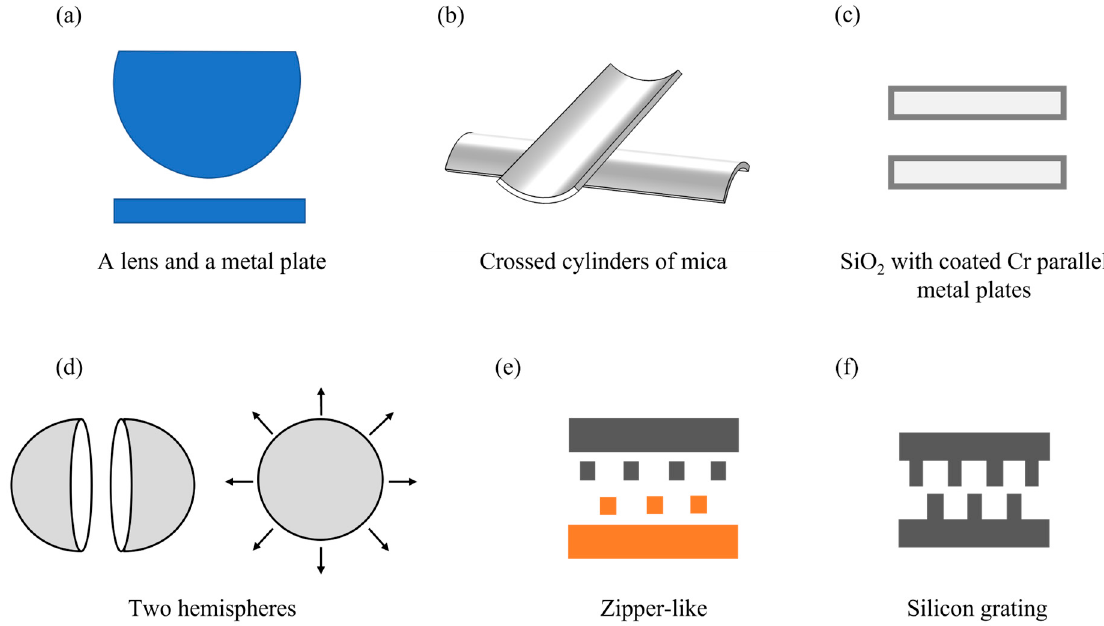
Figure 2. Examples of different geometries demonstrating the existence of Casimir forces: ( a ) a lens and a metal plate [21], ( b ) two crossed cylinders of mica [27], ( c ) two metal plates [23] ( d ) two hemispheres [24], ( e ) a zipper-like geometry [25], and ( f ) a MEMS comb actuator via a silicon grating geometry [26]. All subfigures have been redrawn from the respective references.